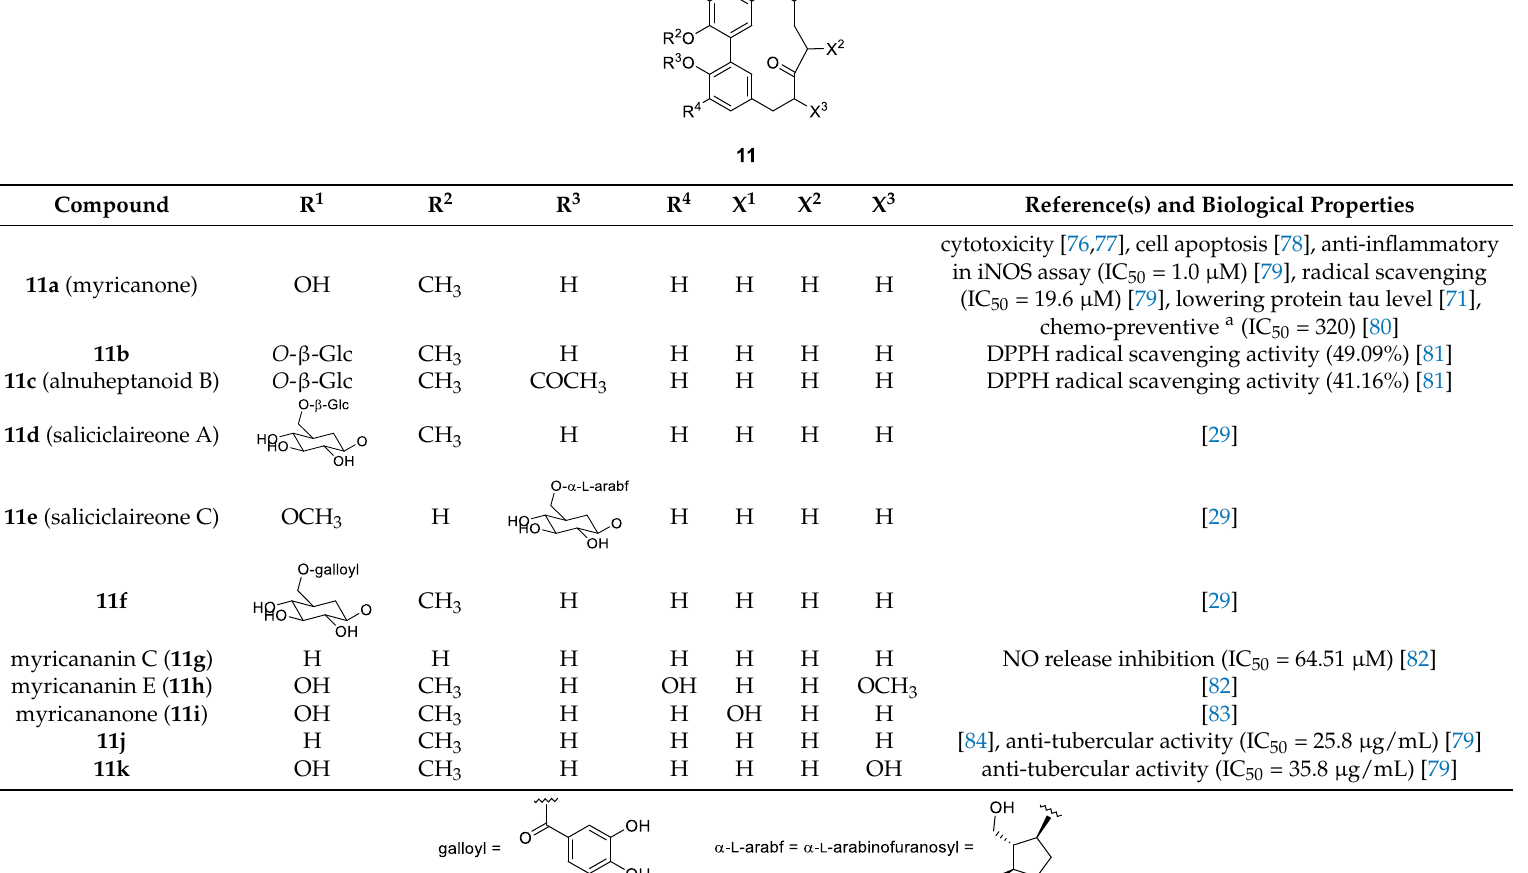
Table 3. The derivatives of myricanone ( 11a ) and their biological properties.